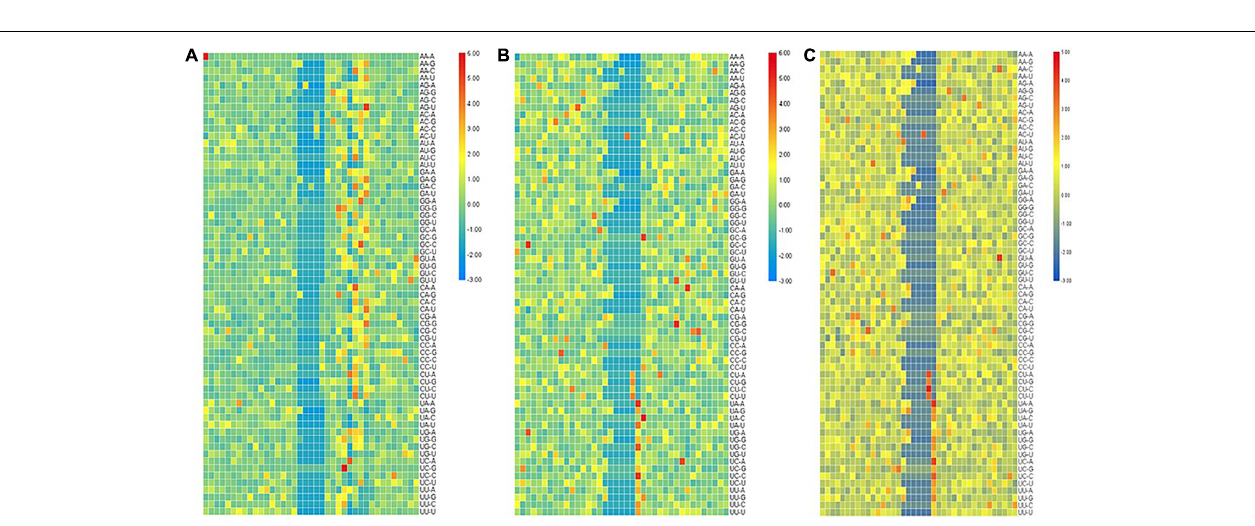
FIGURE 1 | The flow chart of m6A site prediction. (A) The construction of second-order Markov model ( M P and M N ) based on m6A sequence and non-m6A sequence. (B) The prediction for a test sequence. The sequence “GUAUAUAACUUUUUUCUUCAAGGAGCAGGUGUCUGCCUAA” is used as an example to explain the prediction process.